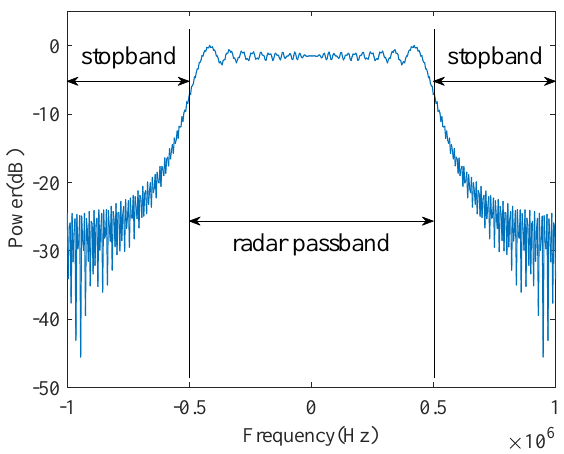
Figure 3. Spectrum of linear frequency modulated (LFM) radar